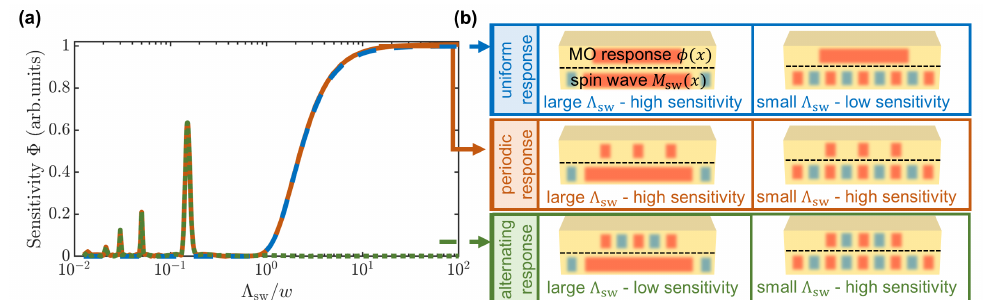
Figure 1. Comparison of the magneto-optical sensitivity to the spin waves of different wavelengths. ( a ) Estimation of the magneto-optical sensitivity calculated using Equation (1) in various cases: uni- form φ ( x ) response of a bare film (blue line), localized sign-constant periodic φ ( x ) response (orange line) and alternating-sign φ ( x ) response (green line). ( b ) Scheme illustrating how the wavelength of the spin wave and type of φ ( x ) response cause different magneto-optical sensitivities. A more detailed explanation is provided in the